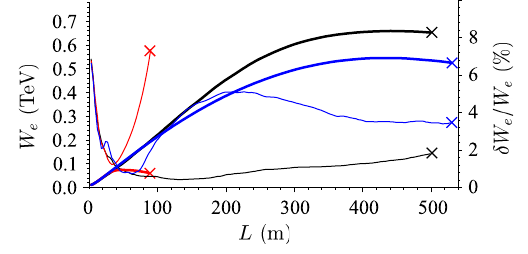
charge.FIG. 12. (Color) Witness energy (thick lines) and energy spread (thin lines) versus traveled distance for the optimum acceleration (black), no density tapering and n 0 ¼ 10 15 cm (cid:1) 3 (blue), and no quadrupole focusing